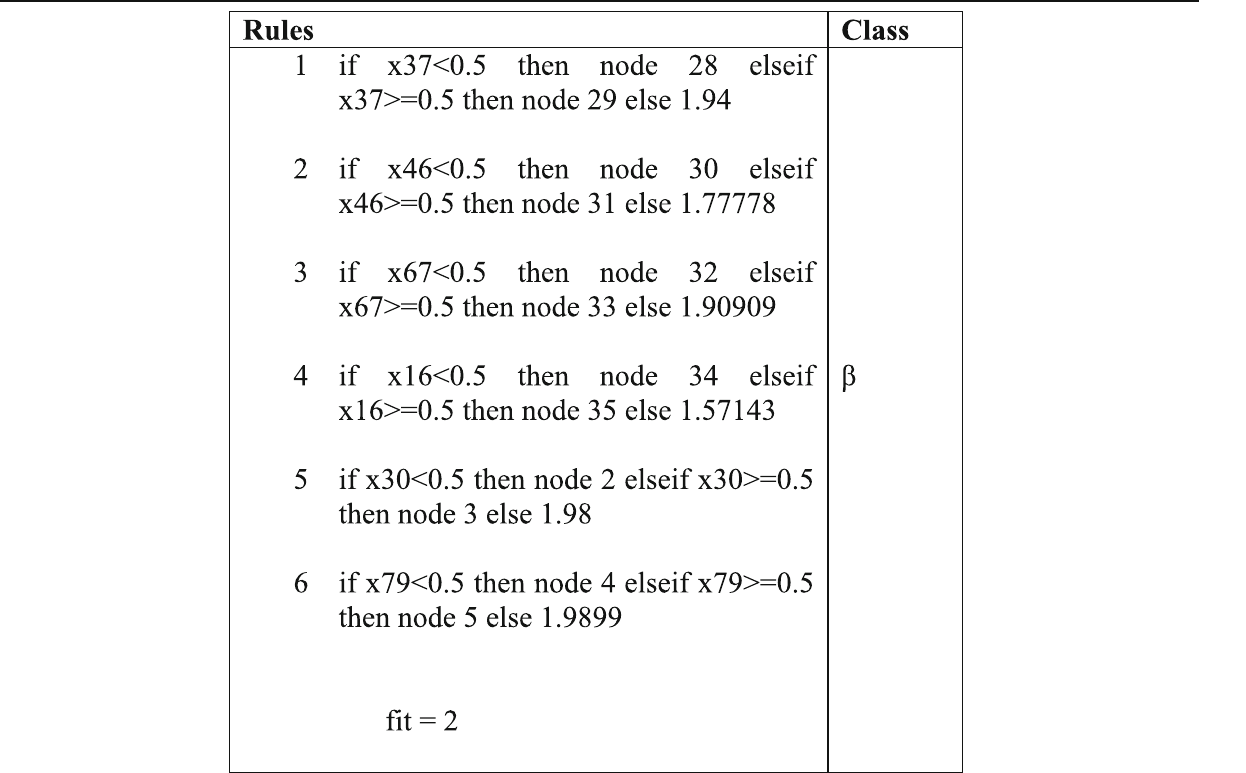
Table 5 Rules produced by the decision tree for the E/~E